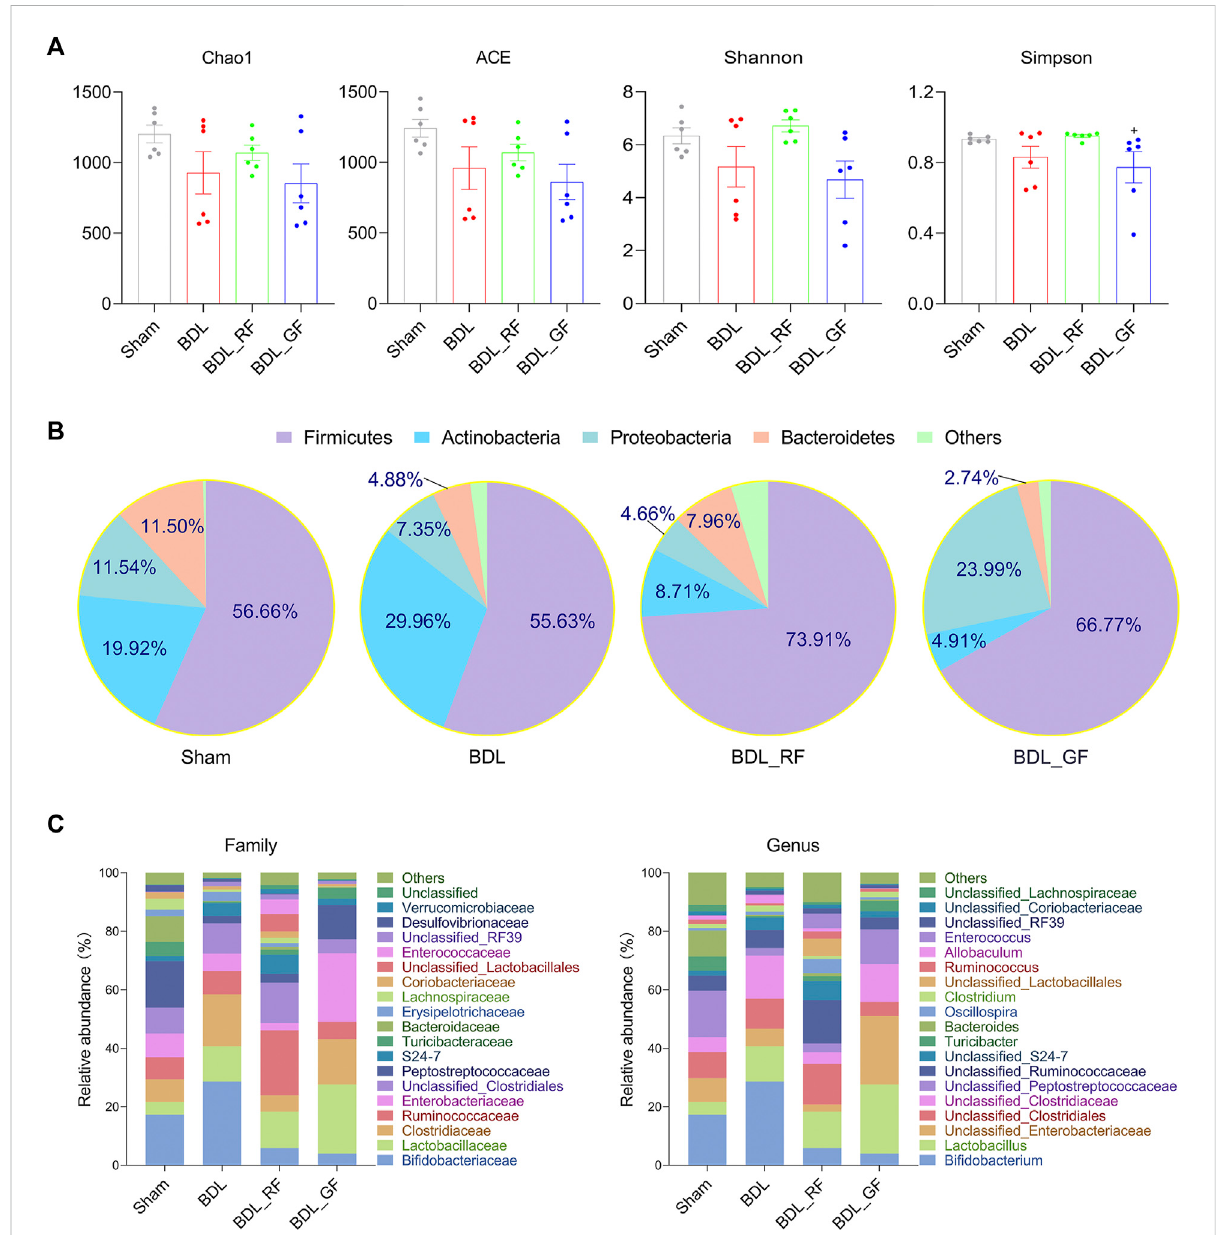
FIGURE 6 Comparison of gut microbiota pro fi le between the four groups. (A) The Chao1 and abundance-based coverage estimator (ACE), as well as the Shannon and Simpson index. (+: p < 0.05, GF_BDL compared with the RF_BDL group, n = 6). (B) Phylum level microbiota composition. Data are the means, mainly showing the top 5 species in relative abundance. (C) Family and genus level microbiota composition. Data are the means, mainly showing the top 20 species in relative